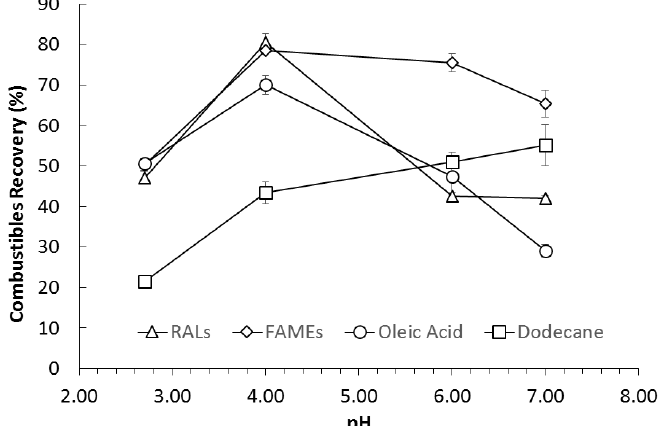
Figure 5. Combustibles recovery as a function of pH for RALs, FAMEs, oleic acid, and dodecane collectors at a fixed dosage of 2.79 kg/t.